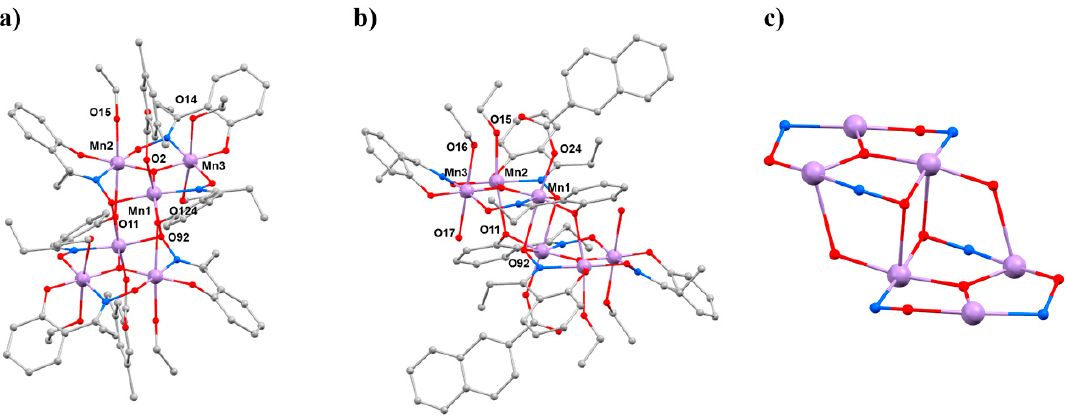
Figure 2. ( a ) The molecular structure of complex 1 . ( b ) The molecular structure of complex 2 . ( c ) The metallic skeleton common to 1 and 2 . Colour code: Mn = lilac, O = red, N = blue, C = grey. H atoms are omitted for